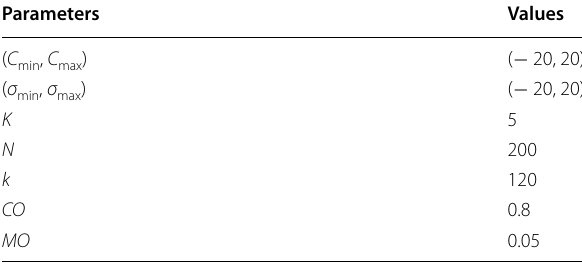
Table 1 The initialization setting of NSGA2-SVM parameters Parameters